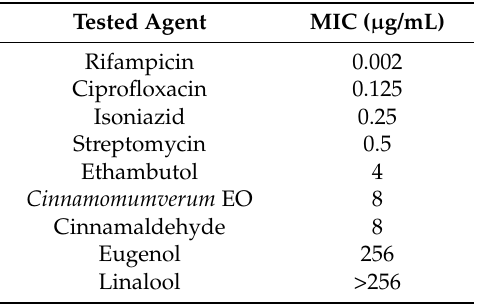
Table 1. The MIC values of antibiotics, Cinnamomumverum EO, cinnamaldehyde, eugnol and linalool determined for M. tuberculosis